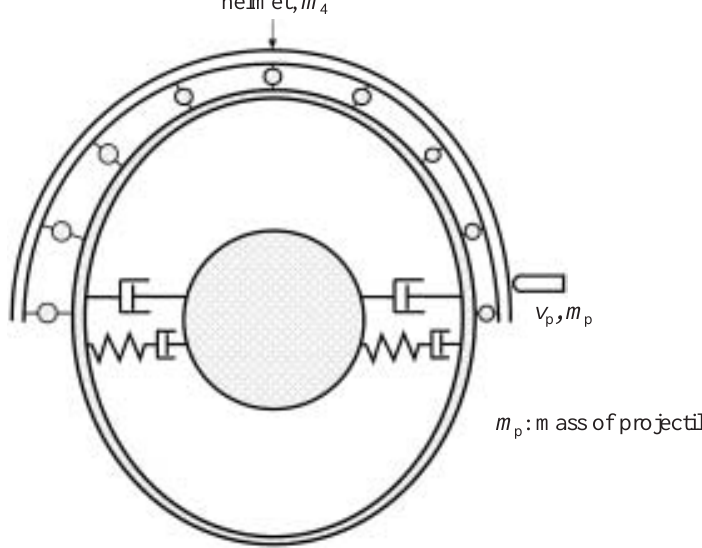
Fig. 1. Helmeted head impacted by a nonpenetrating projectile.